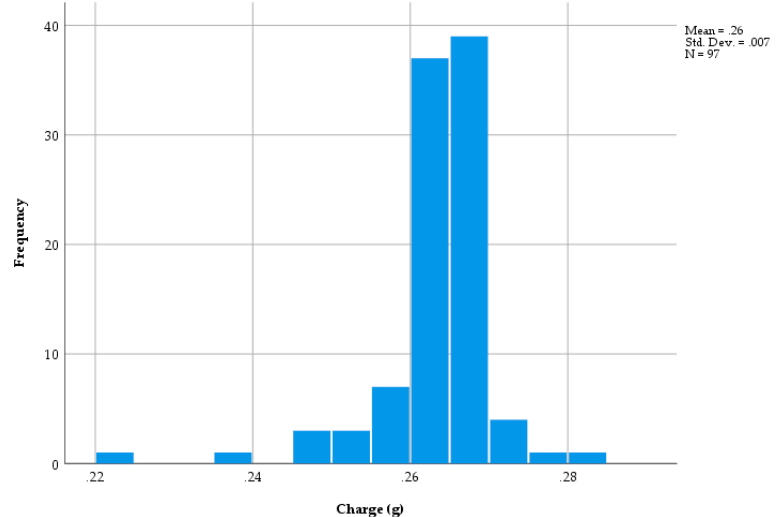
Figure 8. The distribution of charge weights (97 Green 3.00 grain cartridges) (g).